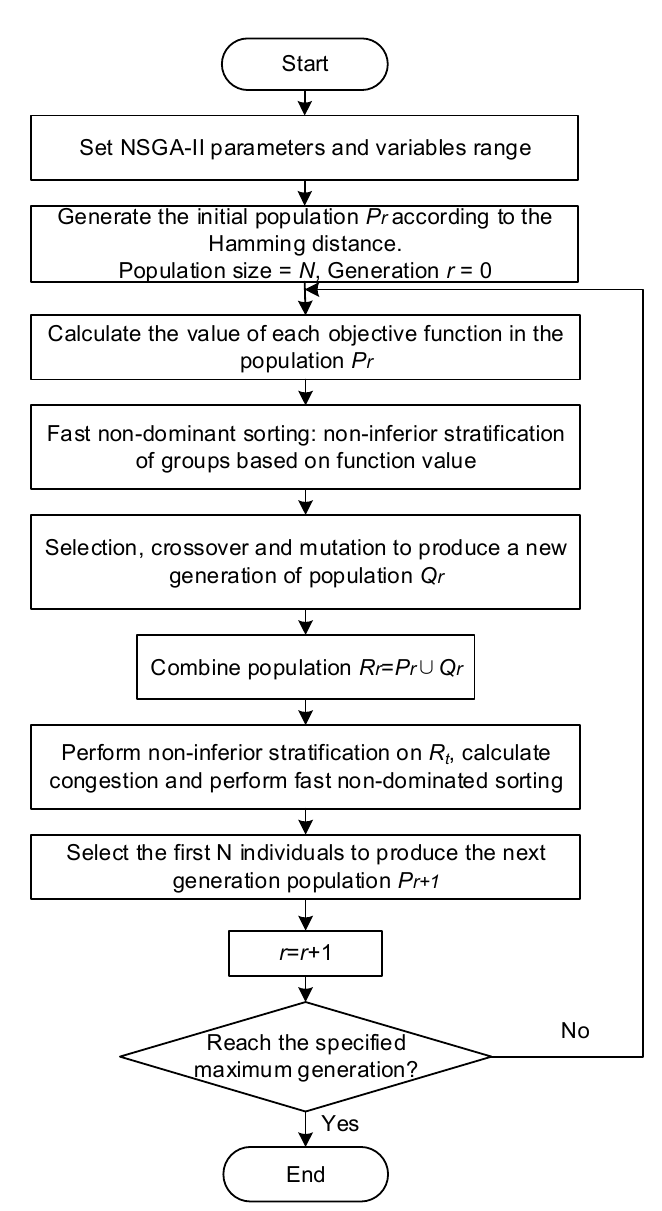
Figure 1. Solution flow chart.